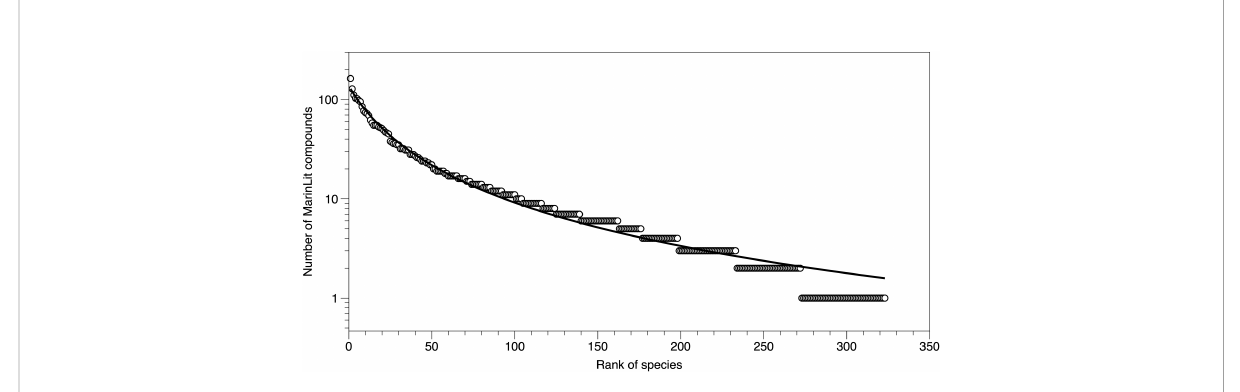
FIGURE 2 Number of compounds in different cnidarian species ranked from high count to low count species. The fi tted line is a Zipf-Mandelbrot relationship (r D 99%), which described the pattern more closely than alternative statistical